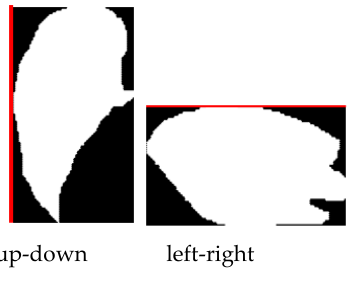
Figure 8. Long side definition.